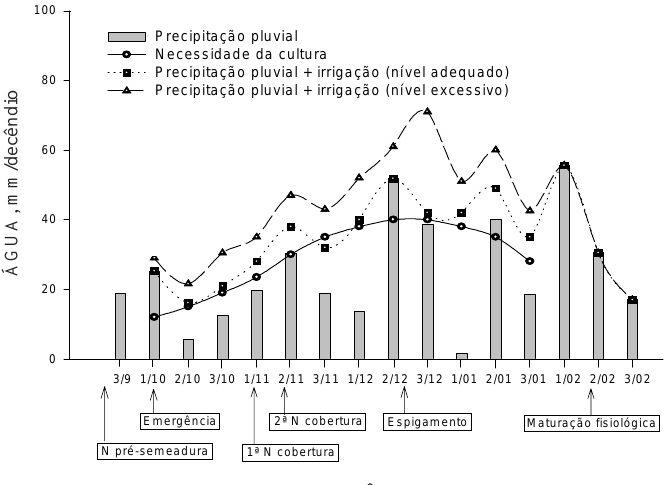
Figura 1. Precipitação pluvial, necessidade da cultura e quantidade de água aplicada nos níveis de adequada e excessiva disponibilidade hídrica durante o ciclo de desenvolvimento do milho.